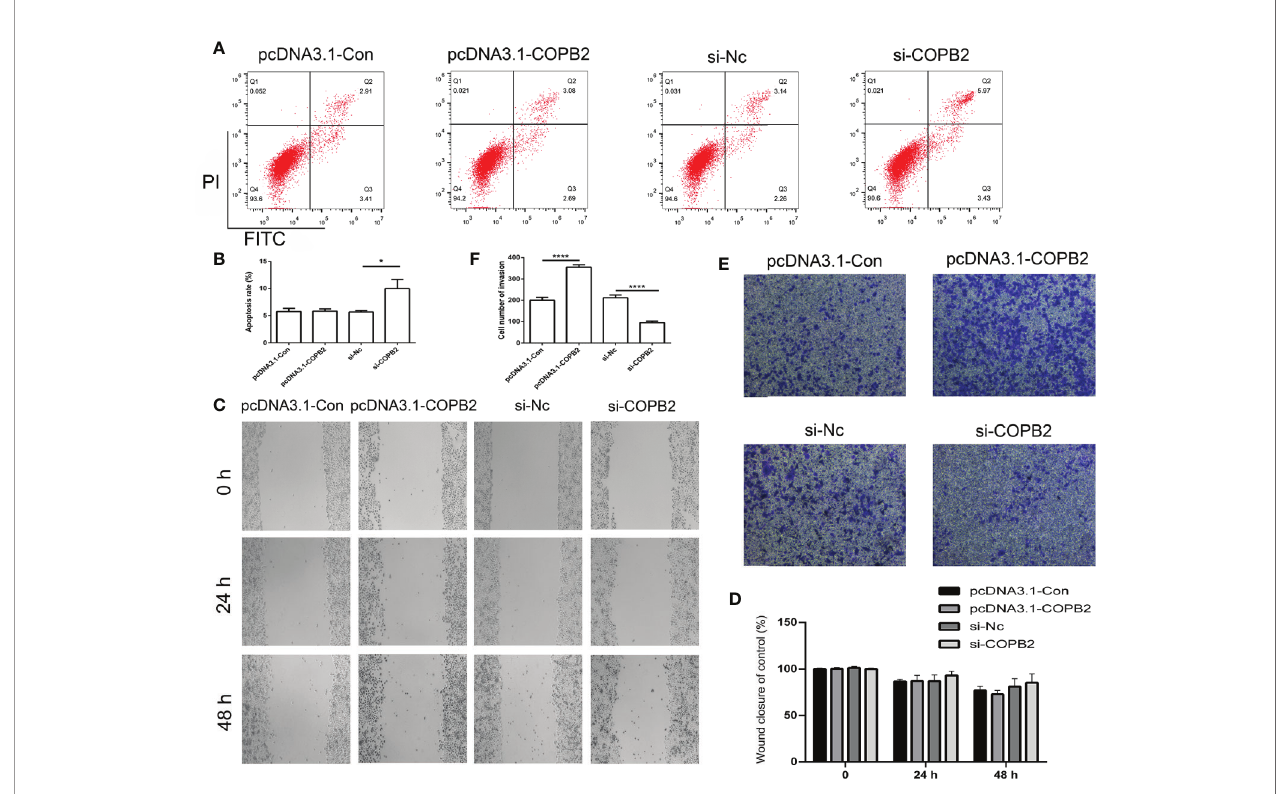
FIGURE 5 | Analysis of cell apoptosis, migration and invasion after knockdown and overexpression of COPB2 . Cell apoptosis was analyzed in the pcDNA3.1-Con, pcDNA3.1-COPB2, si-Nc, and si-COPB2 group (A, B) . Cell migration was analyzed after si-COPB2 and pcDNA3.1-COPB2 were transfected (C, D) . The cell invasion was analyzed in pcDNA3.1-Con, pcDNA3.1-COPB2, si-Nc, and si-COPB2 group (E, F) . Statistical analysis of the percentage of cell invasion (D) . The data are represented as the mean ± SD (n = 3). * ( p < 0.05) and **** ( p < 0.0001) indicate statistically signi fi cant